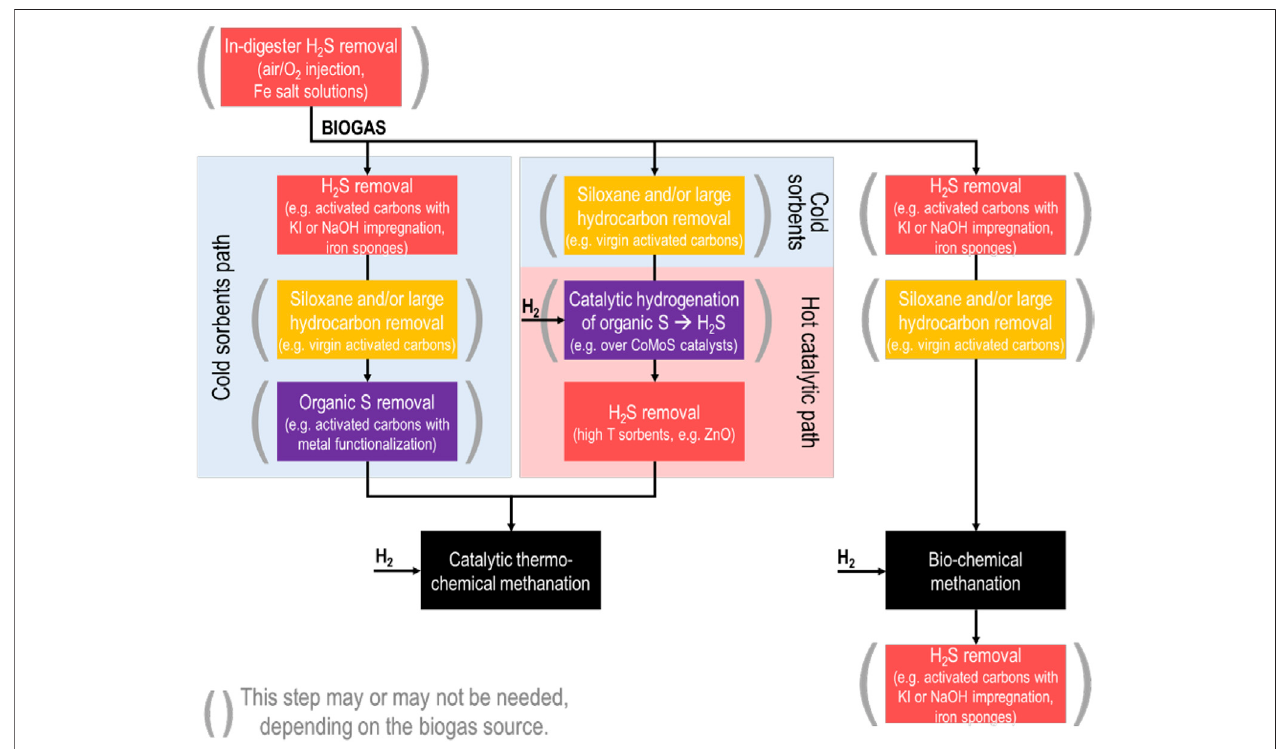
FIGURE 1 | Broad overview of biogas cleaning steps which may be needed, depending on the biogas source, for Power-to-CH 4 conversion of biogas. Biogas cleaning needs for bio-chemical methanation are dictated by natural gas grid purity requirements rather than the methanation process.